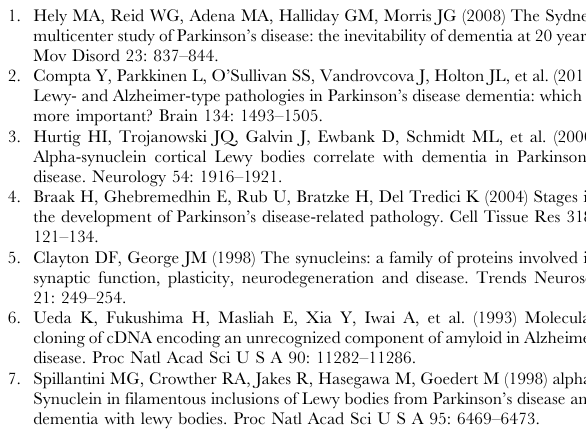
Figure S2 Levels of a -syn were measured in insoluble fractions from human brain samples (n =10) by sequen- tial extraction and ELISA. A representative plot of the correlation of B max values for [ 125 I]SIL23 binding to levels of total insoluble a -syn quantified from ELISA is shown (Pearson correlation coefficient R= 0.98, p = 0.0008). Results were verified with more than two independent experiments. Lower levels of a - syn measured in ELISA may result from low recovery during sequential extraction or incomplete solubilization of fibrils. Figure S3 Binding affinities for SIL analogues in human PD brain samples determined by competitive binding assays with [ 125 I]SIL23. Homogenized insoluble fractions from human PD brain samples were incubated with 200 nM [ 125 I]SIL23 and increasing concentrations of competitor ligands. Representative plots are shown for competition with SIL22 ( A ), SIL26 ( B ), SIL3B ( C ), and SIL5 ( D ). The amount of bound radioligand is plotted as a function of the concentration of competitor ligand in the incubation mixture. The results were verified with two independent experiments.